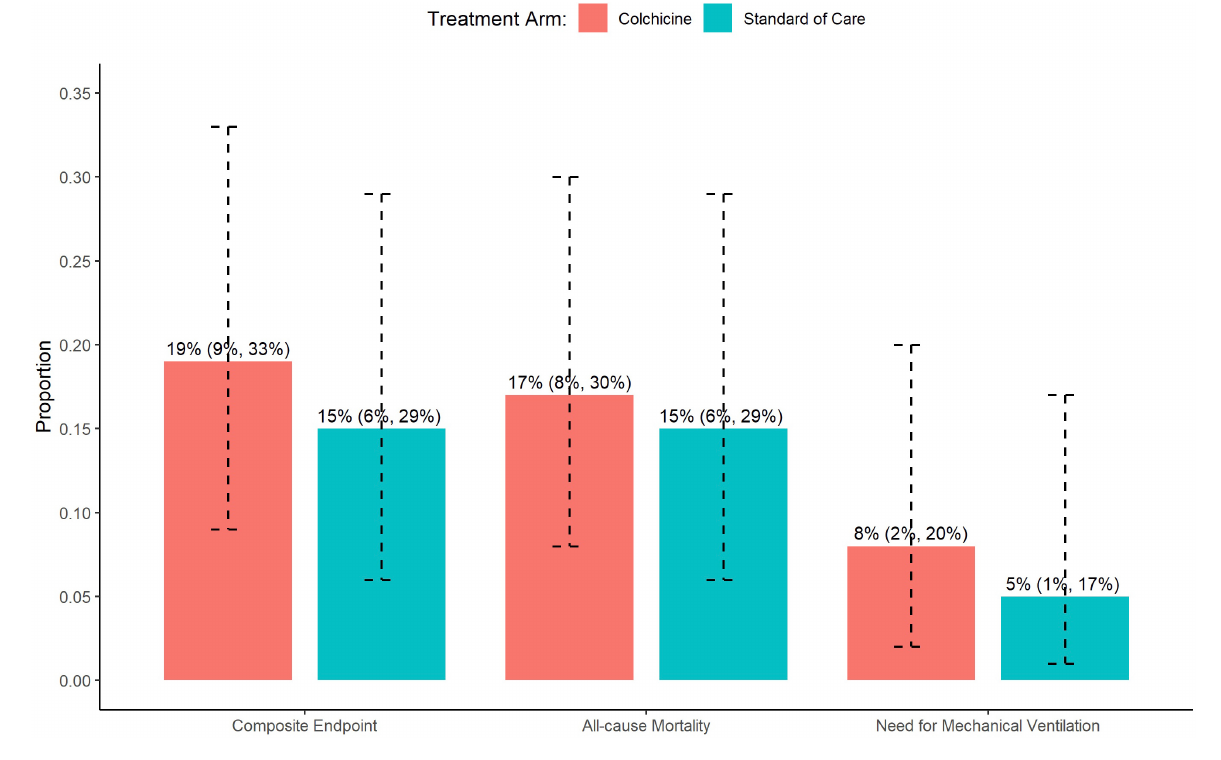
TABLE 2 | Adjusted primary and individual component secondary endpoint data*.